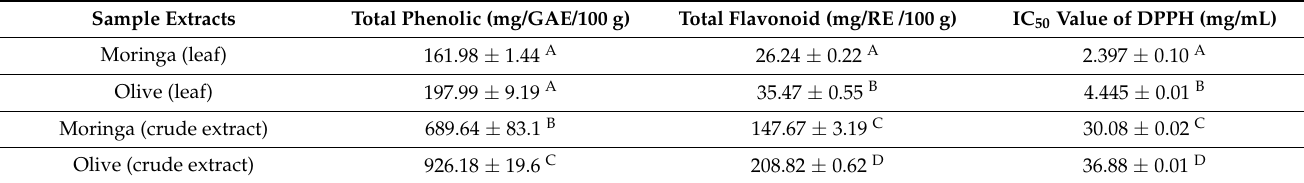
Table 2. The total phenolic and flavonoid content, and the antioxidant activity (IC 50 ) of Moringa and olive leaves, and their crude